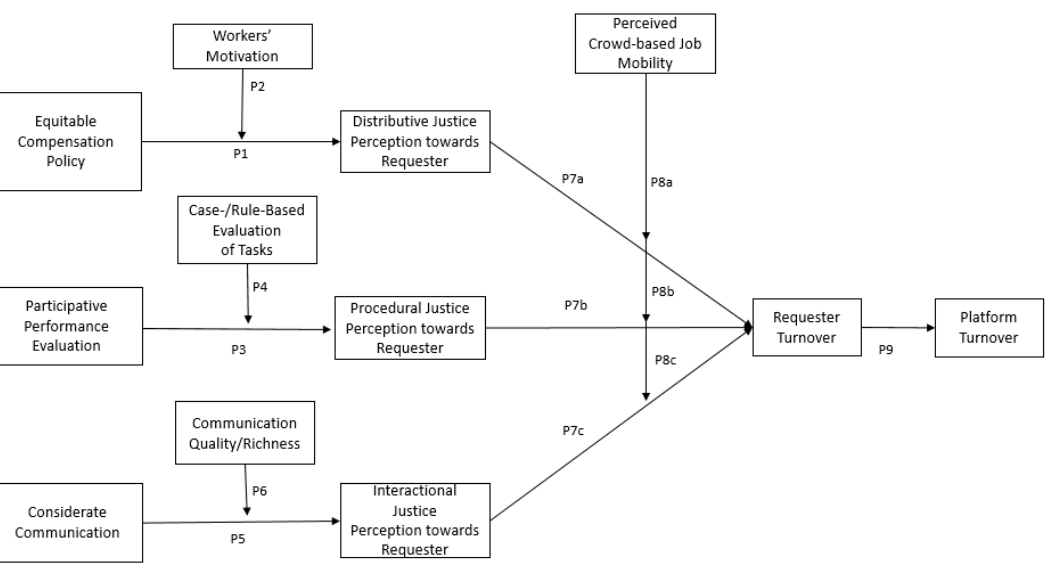
Figure 1. Conceptual Model.